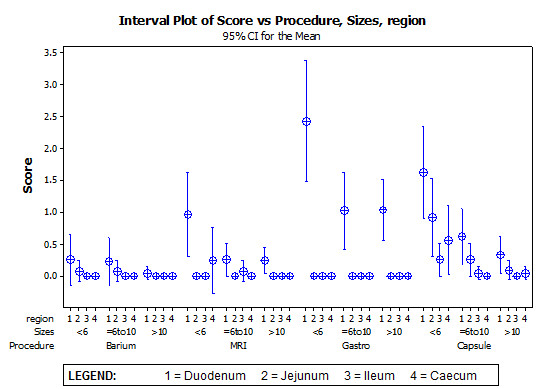
Interval Plot of Score vs Procedure, Sizes, Region.